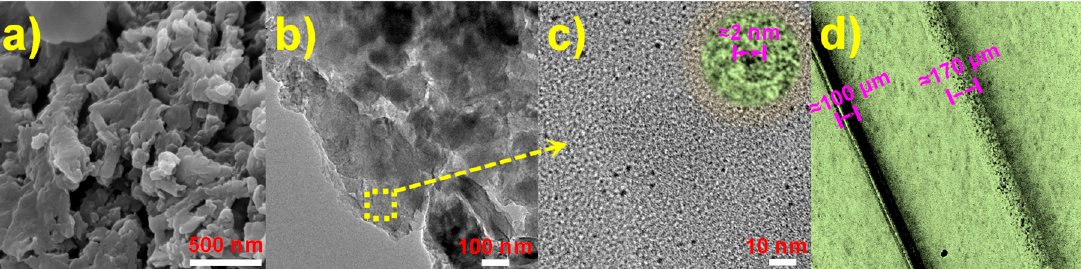
Figure 1. SEM ( a ) and TEM ( b , c ) images of CDs/g-C 3 N 4 composites, magnified TEM image ( c